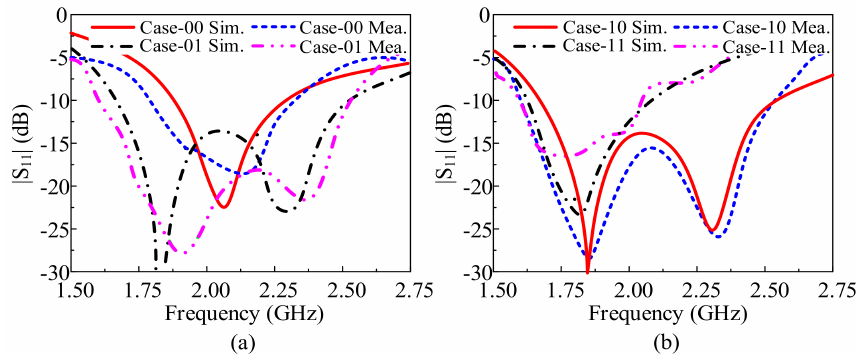
Figure 8. Simulated and measured reflection coefficient responses (S11<–10 dB) of the proposed antenna for different switching cases of the diode, ( a ) case–00, case–01; ( b ) case–10, case–11.